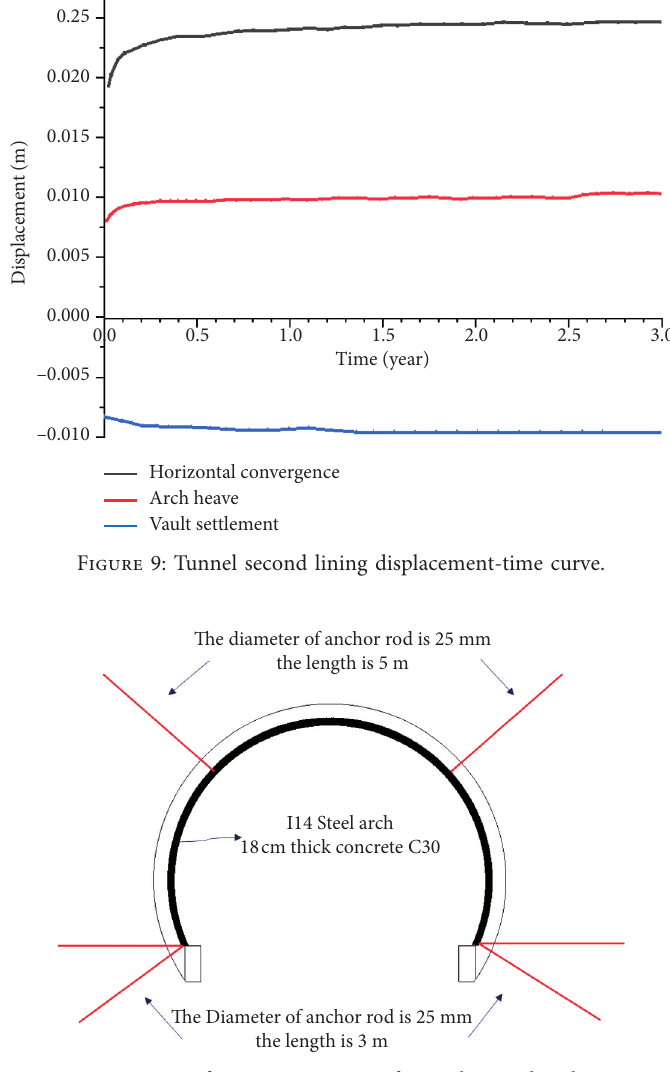
The Diameter of anchor rod is 25 mm the length is 3 m Figure 10: Reinforcement strategy of tunnel secondary